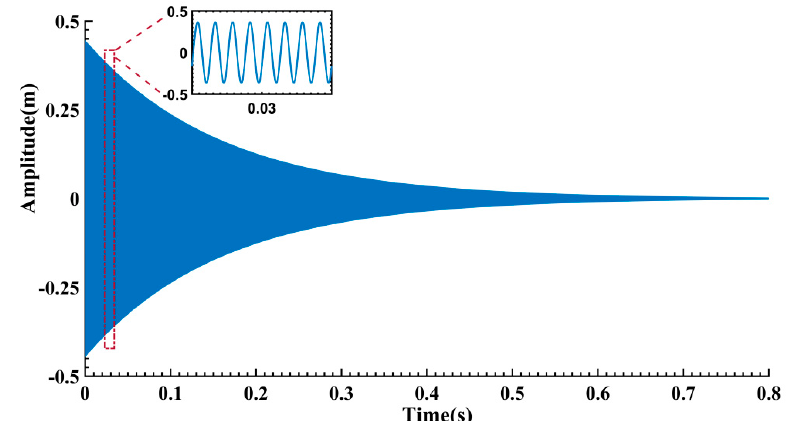
Figure 3. Typical free vibration signal.